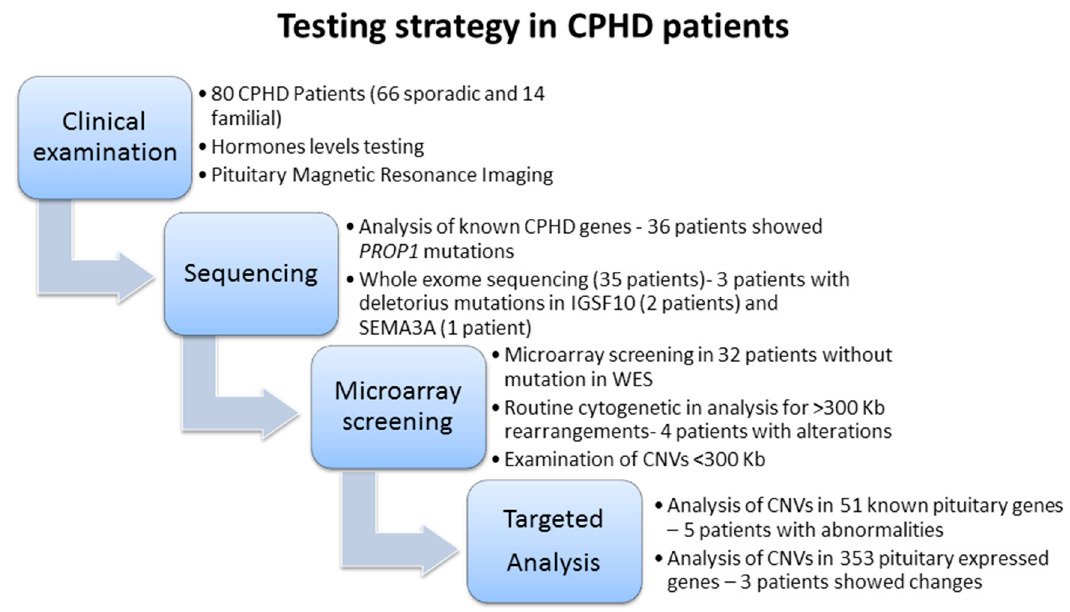
Figure 2. Testing strategy in CPHD